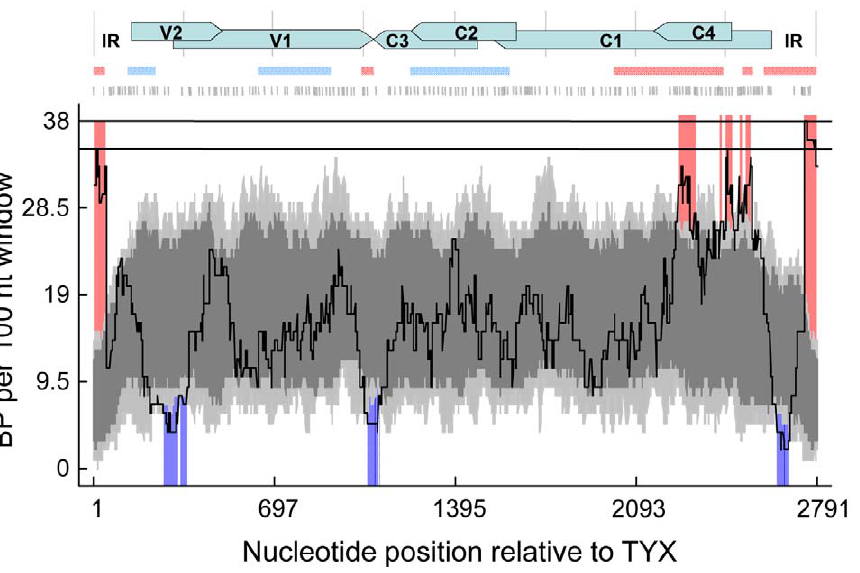
Figure 3. The distribution of 452 unique recombination breakpoints detected within the 50 unique recombinant sequences emerging during Tomatoyellowleafcurlvirus (TYX) and TomatoleafcurlComorosvirus (TOX) co-infections. All detectable unique breakpoint positions are indicated by small vertical lines at the top of the graph. A 100 nucleotide window was moved along the alignment one nucleotide at a time and the number of breakpoints detected within the window region was counted and plotted (solid line). The upper and lower broken lines respectively indicate 99% and 95% confidence thresholds for globally significant breakpoint clusters. Light and dark grey areas respectively indicate the expected 99 and 95 percentiles of expected recombination breakpoint clustering assuming random recombination. Whereas red areas indicate recombination hot-spots, blue areas represent recombination cold-spots. The positions of open reading frames (ORFs; horizontal arrows) and intergenic regions (IR) are represented on the top of the graph. Pink and blue horizontal lines beneath the ORF map respectively delineate the positions of recombination hot and cold spots detectable within begomovirus genomes sampled from nature (from Lefeuvre et al. [8]).